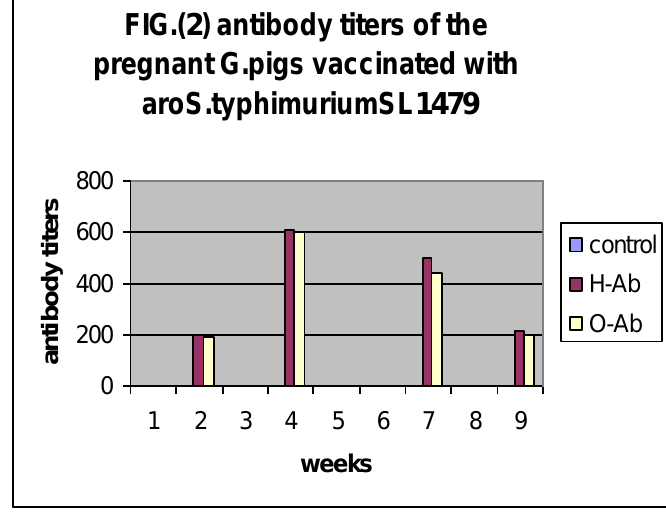
FIG.(2) antibody titers of the pregnant G.pigs vaccinated with aroS.typhimuriumSL1479